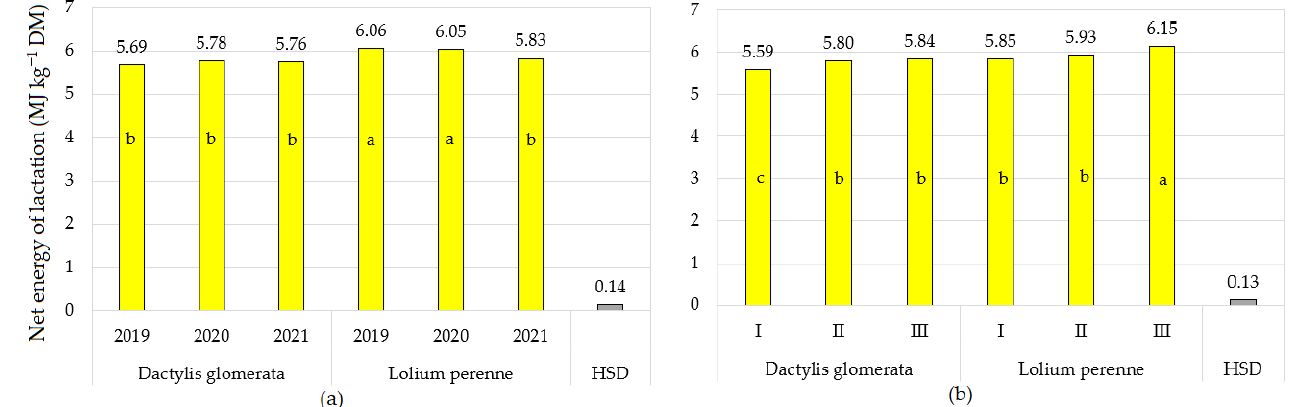
Figure 2. Net energy of lactation of Dactylis glomerata and Lolium perenne in consecutive ( a ) growing seasons ( b ) harvests (MJ kg − 1 DM). Means in columns marked with the same lower-case letters do not differ significantly.